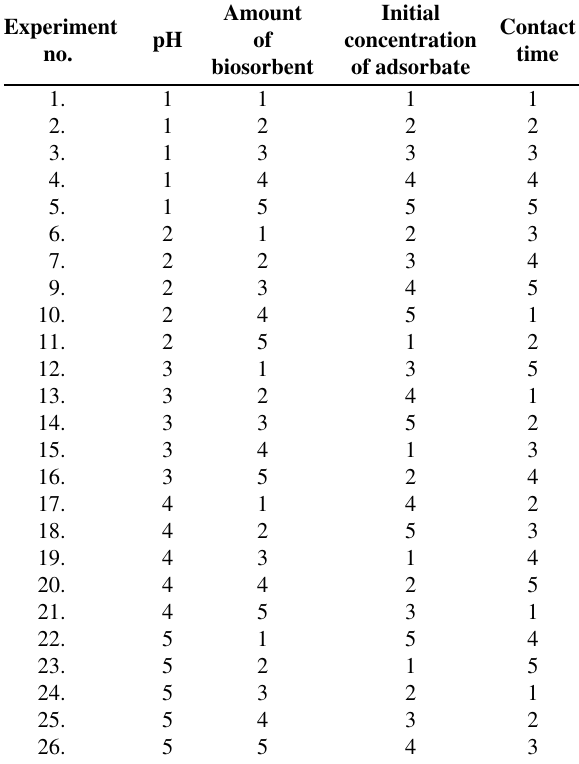
Table 2. L25 Experimental and expected results from Taguchi’s Orthogonal Array (OA) analysis Amount Initial Experiment pH of concentration no.